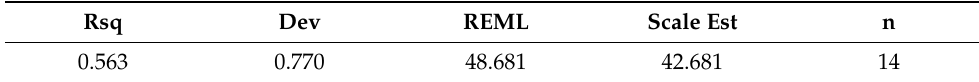
Table 5. Model summary table for spatial GAM.